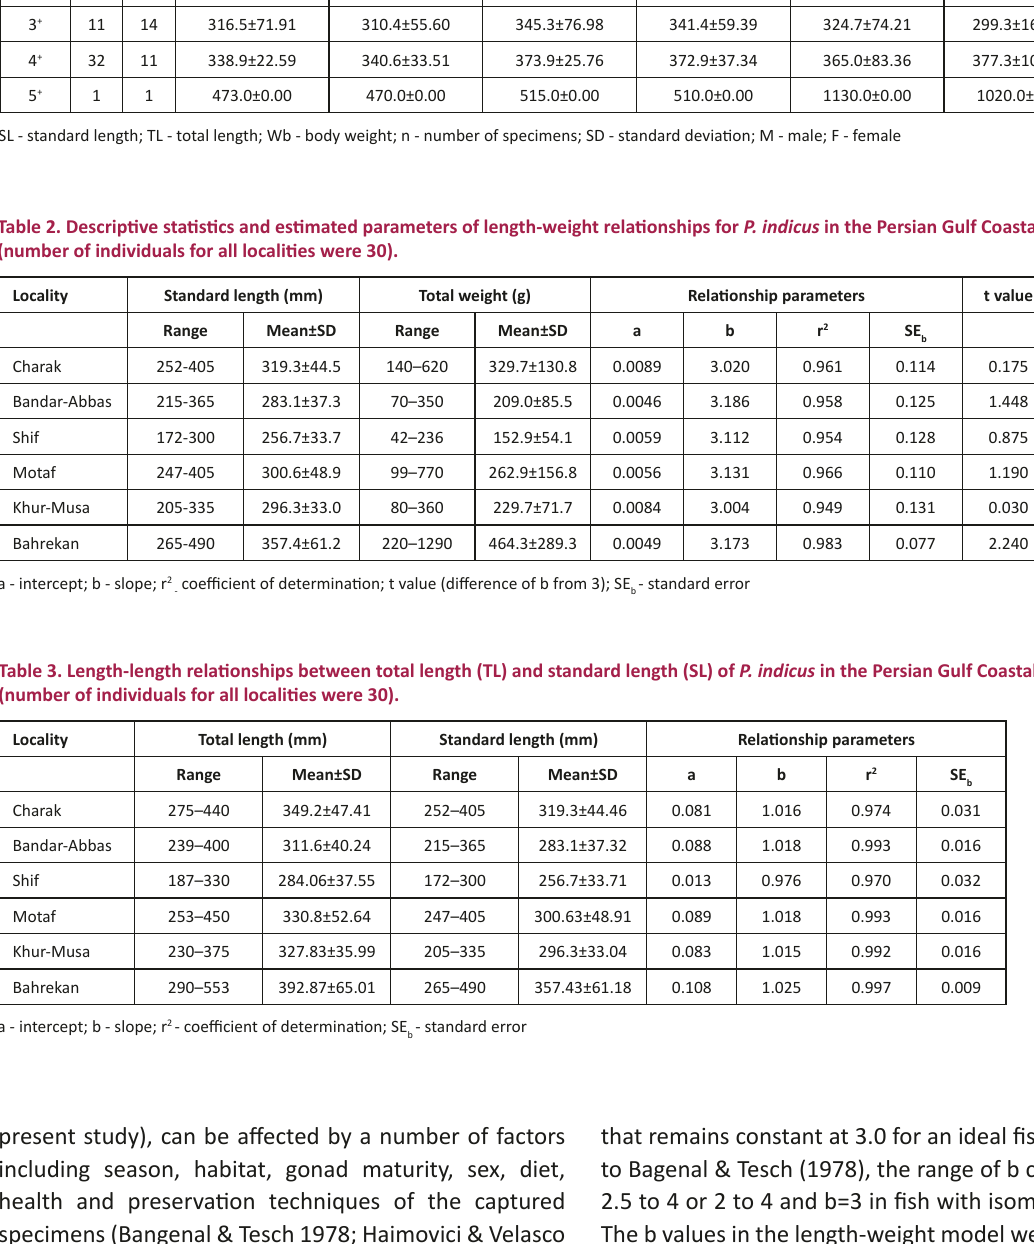
Table 1. Length and weight (mean ± SD) in different age groups of males and females of P. indicus in the Persian Gulf coastal